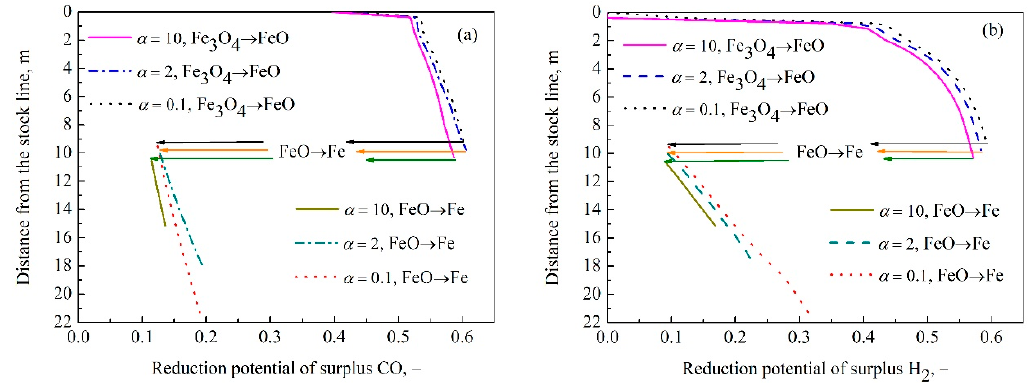
Figure 5. The reduction potential of surplus CO ( a ) and H 2 ( b ) under di ff erent coke reactivity in indirect reduction region.